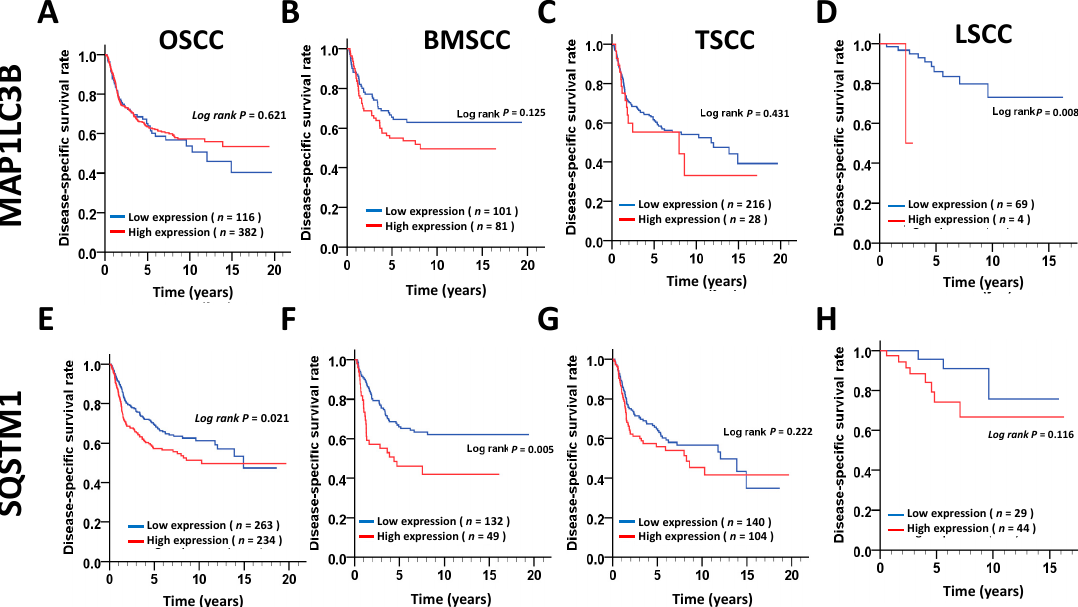
Figure 2. DSS survival curves for MAP1LC3B and SQSTM1 expression in patients with different subsites of OSCC. DSS survival curves of MAP1LC3 ( A – D ) and SQSTM1 ( E – H ) are shown for OSCC ( A , E ) and three main subsites, BMSCC ( B , F ), TSCC ( C , G ) and LSCC ( D , H ). The cutoff values for high or low expression of MAP1LC3B and SQSTM1 in tumor tissues were based on the receiver operating characteristic (ROC) curve.